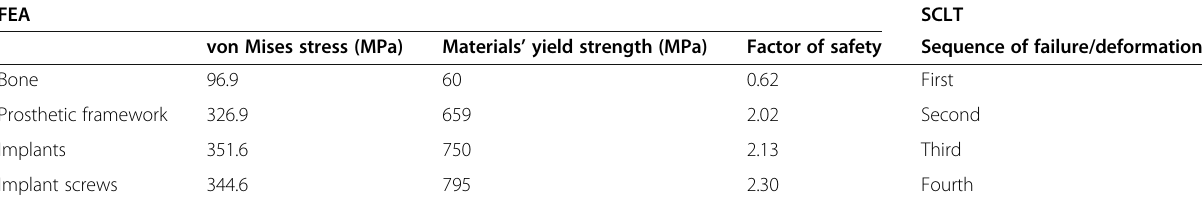
Table 5 Highest stress values according to the von Mises criterion for each reference model part and its relation with the materials ’